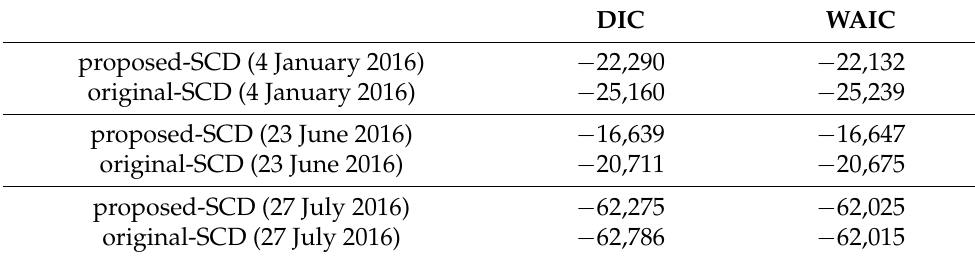
Table 30. Comparison of information criteria (AGH, Tokyo, Japan).